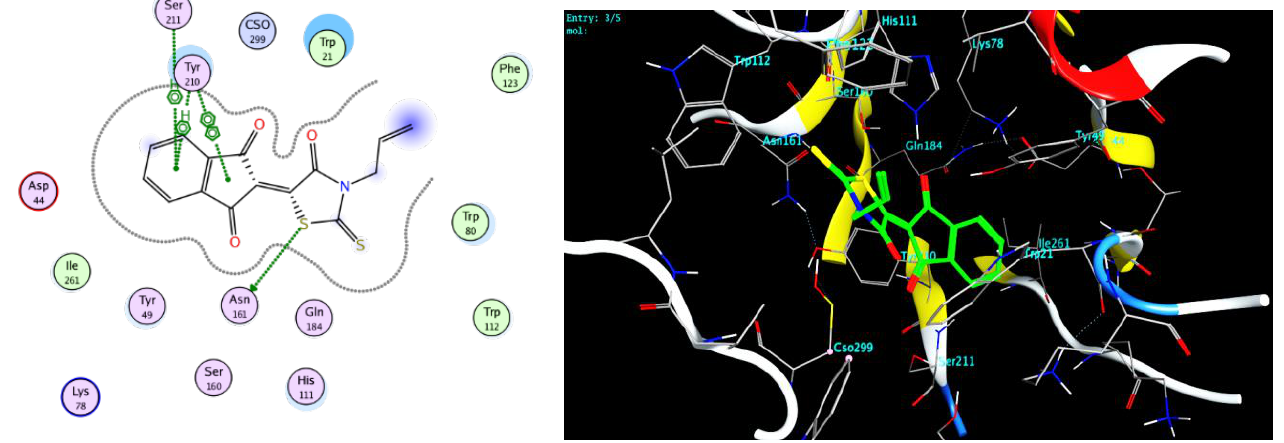
Figure 6. 2D and 3D docking of compound 5d with AKR1B10.